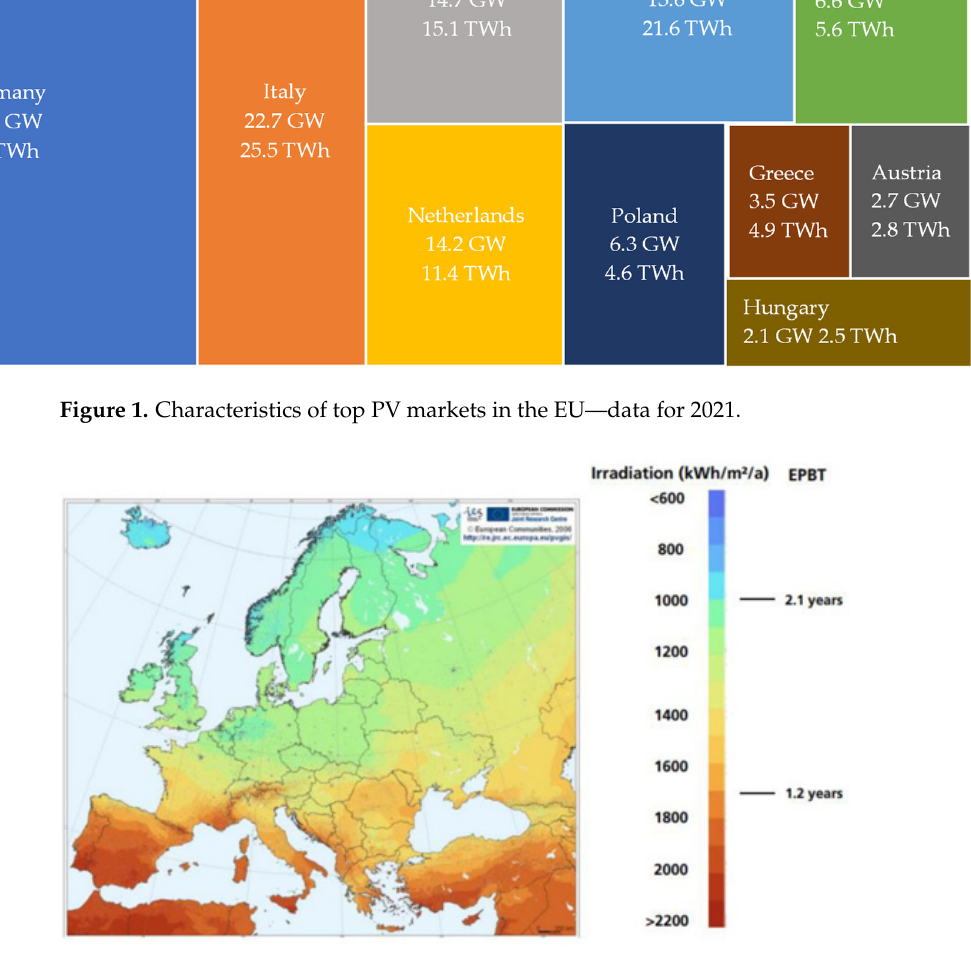
Figure 2. Irradiation and EPBT (energy payback time) in European countries according to the JRC European Commission [20].